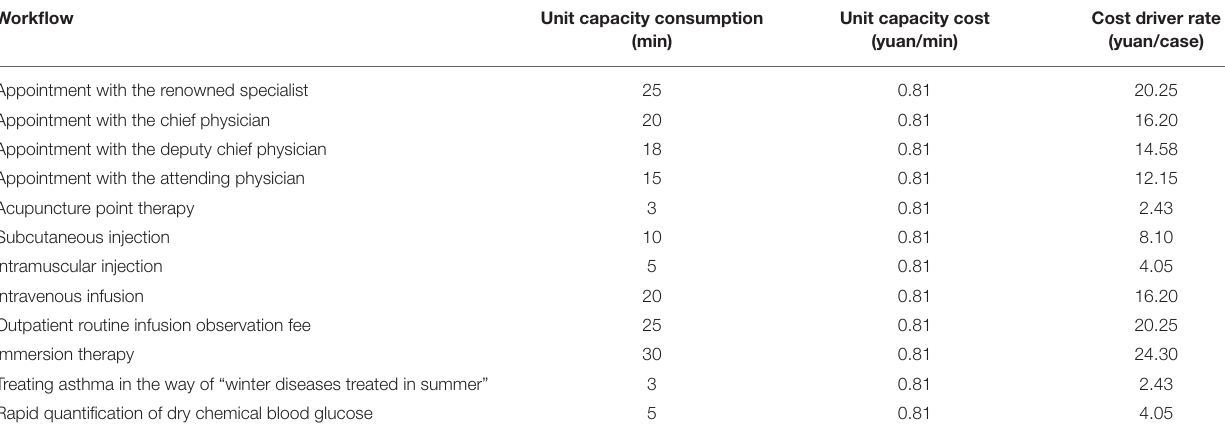
TABLE 5 | Cost driver rate of each activity in TCM departments.